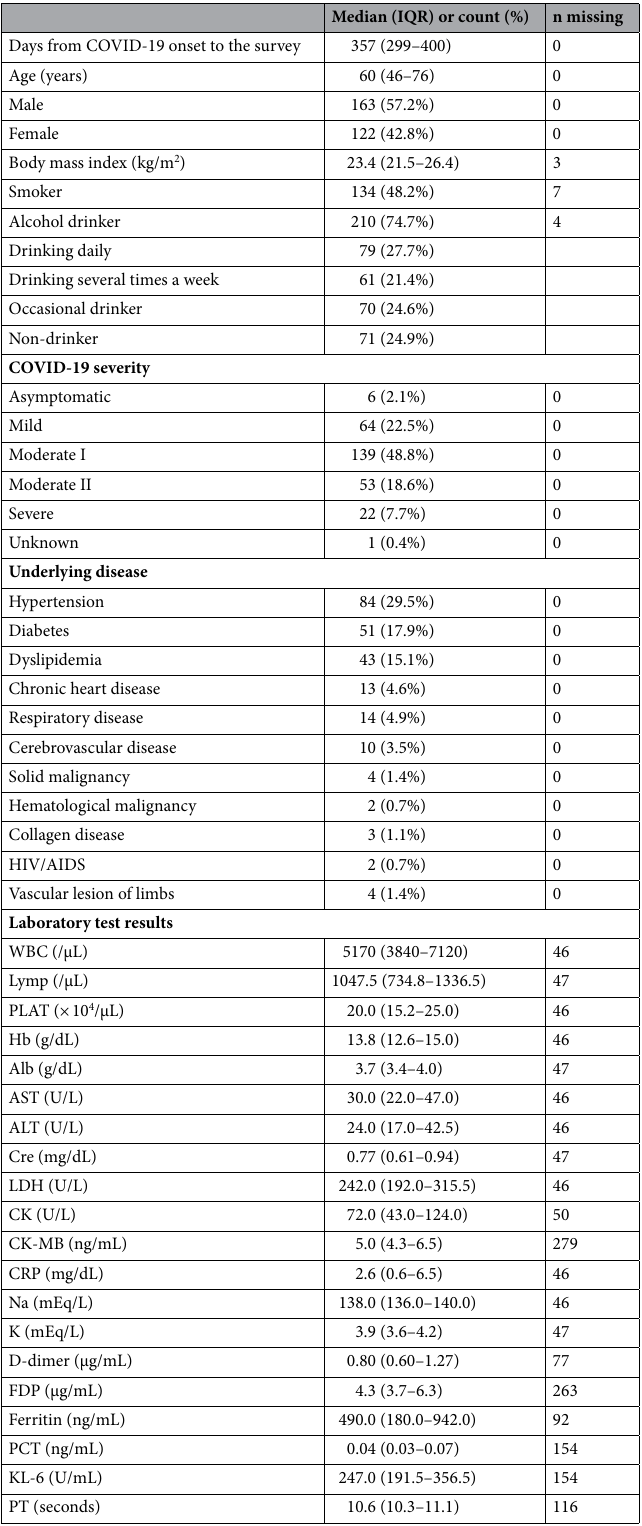
Table 1. Characteristics of study participants (N = 285). AIDS, acquired immunodeficiency syndrome; Alb, albumin; ALT, alanine aminotransferase; AST, aspartate aminotransferase; CK, creatine kinase;